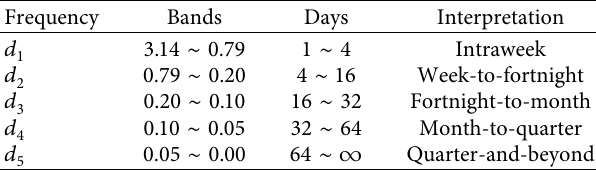
Table 1: Interpretations to frequency bands. Frequency Bands Days